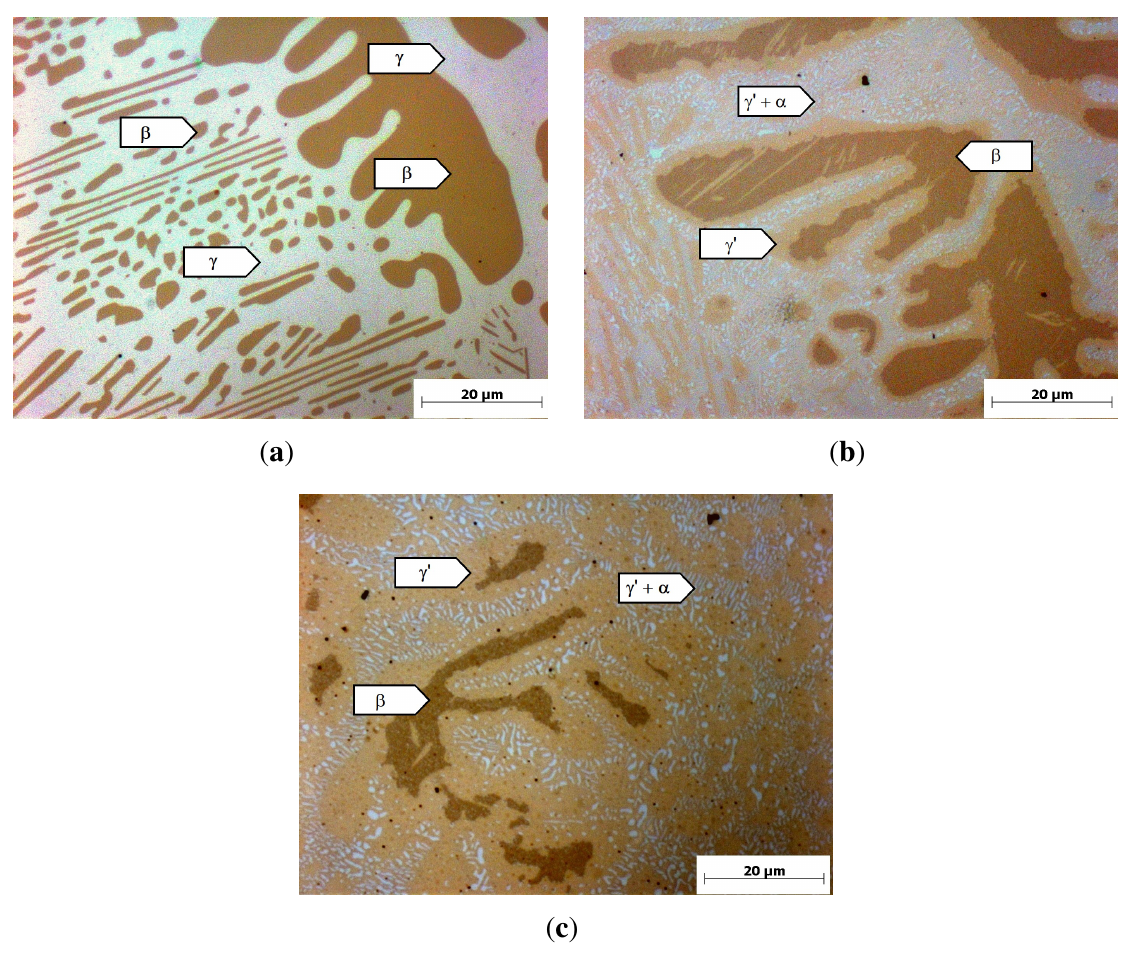
Figure 3. Optical micrographs of the reference-alloy Ni-22%Cr-10%Al after different heat treatments. The samples were quenched in water after each heat treatment and were